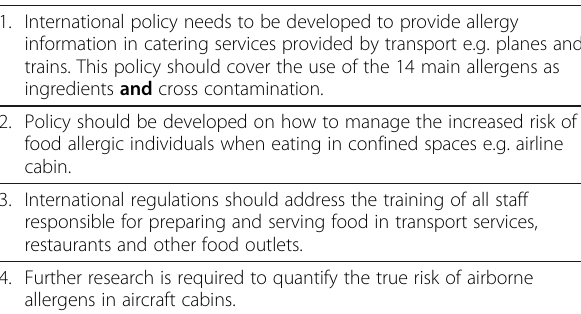
Table 1 Recommendations arising from this study